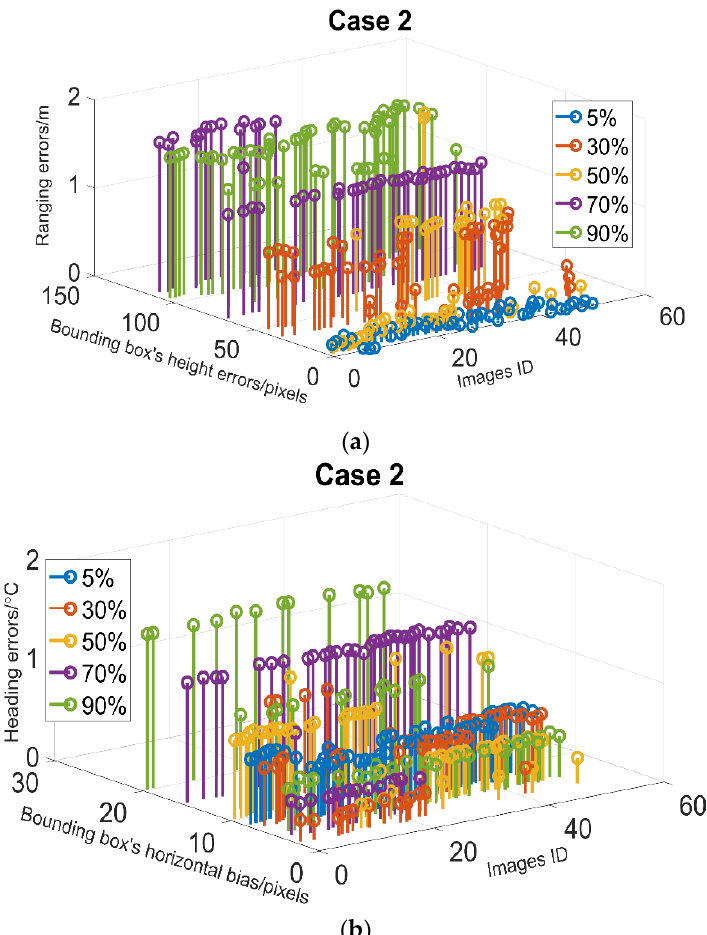
Figure 11. The effect of obstruction under five overlap ratios of target and the pedestrian. ( a ) Ranging error; ( b ) angulation error.